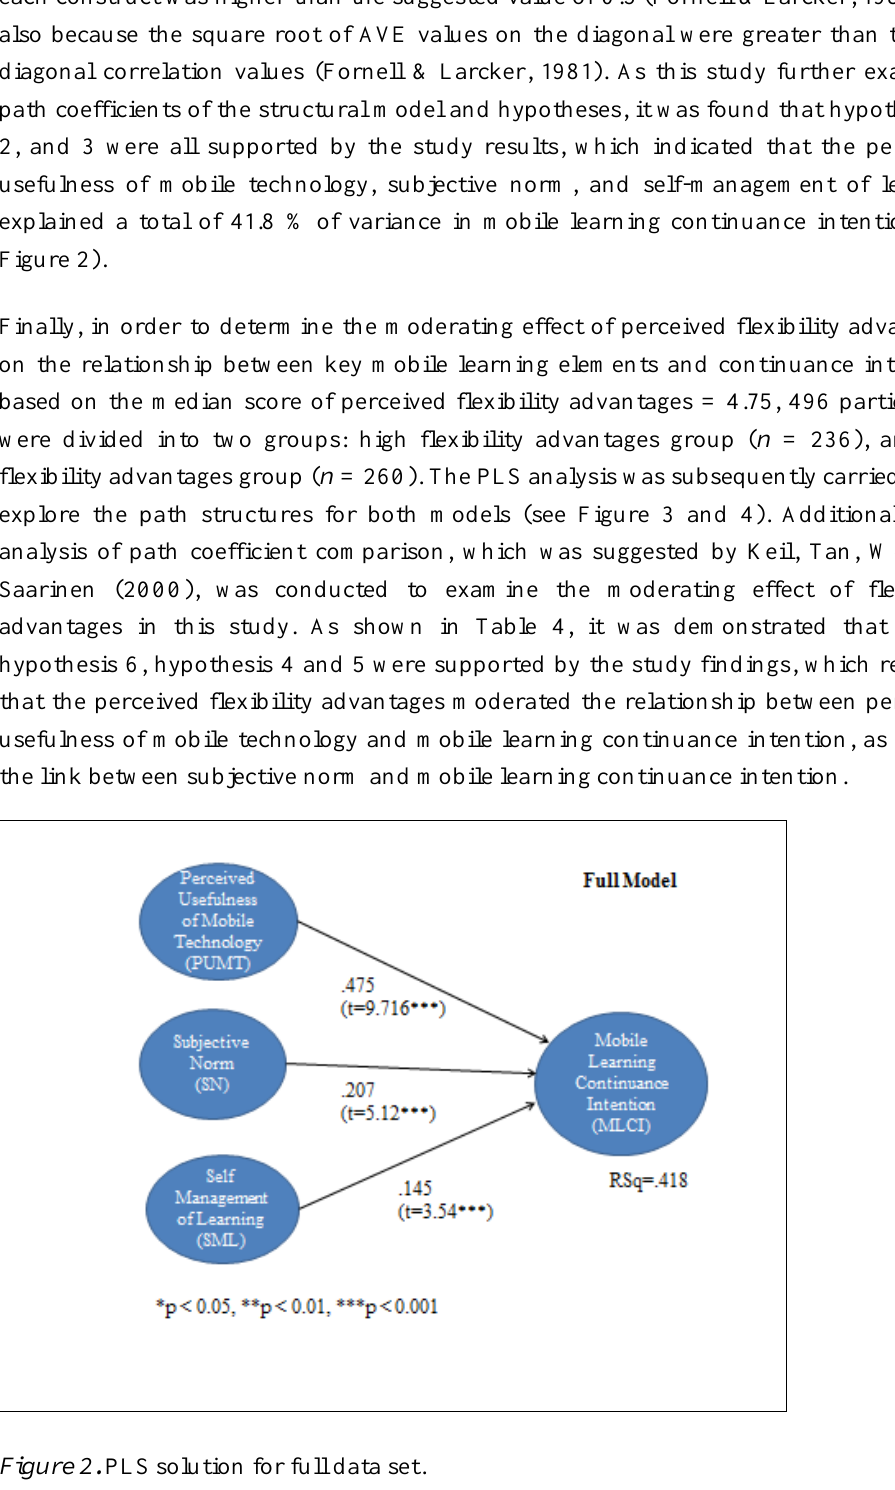
Figure 2. PLS solution for full data